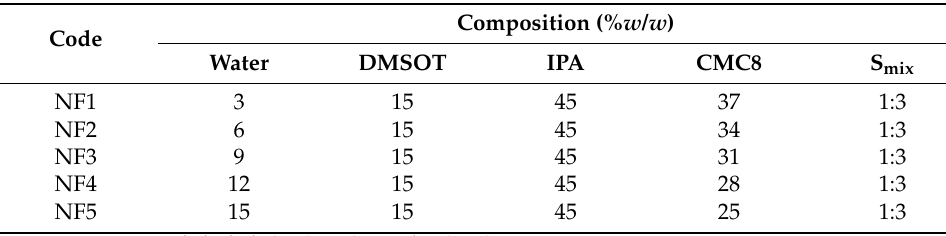
Table 1. Summary of nanoemulsions (water/DMSOT/IPA/CMC8)